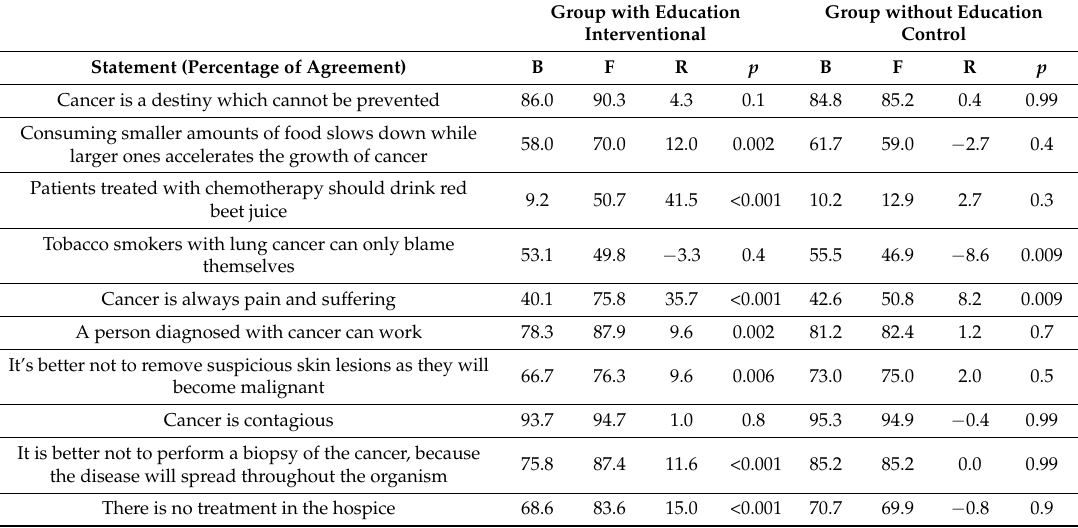
Table 2. Impact of the educational intervention to answer of particular questions in interventional and control